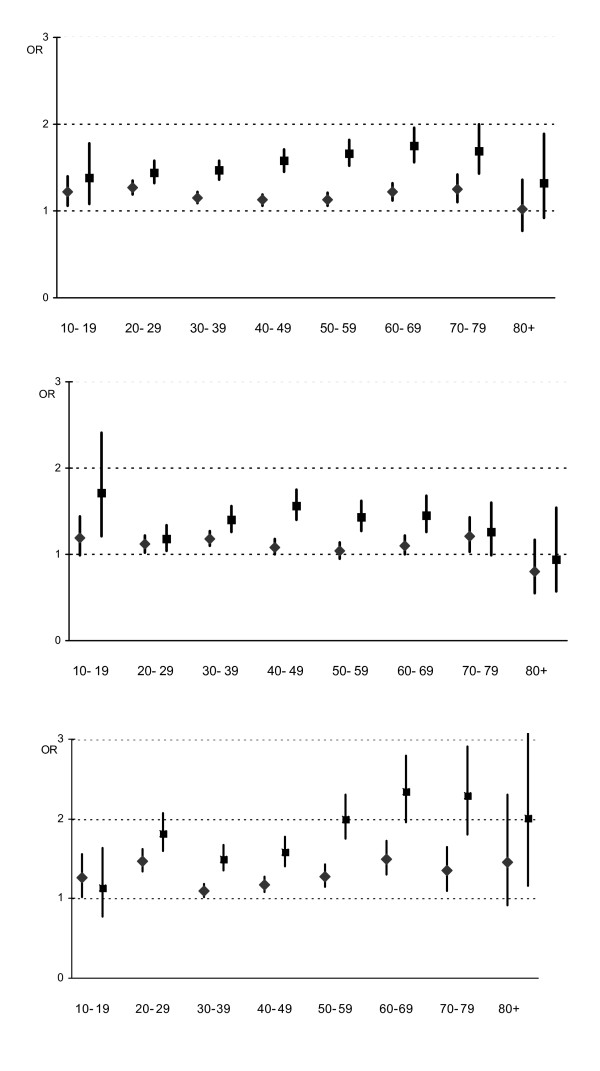
Odds of current smoking among individuals living in small cities (◆) and metropolitan (■) areas compared to inhabitants of rural areas. Results are given for the whole study population (Figure 1a) as well as the male (Figure 1b) and the female (Figure 1c) subpopulations. Data are odds ratio and 95% confidence intervals. OR estimates were controlled for marital status, school education, income and residency in East Germany.